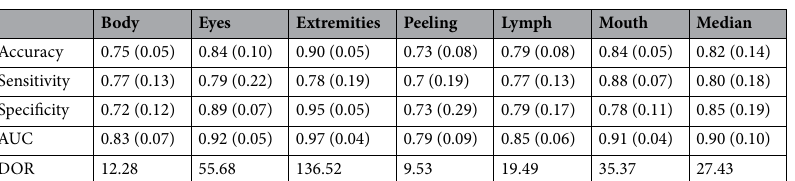
Table 2. Summary of tenfold cross validation results across KD clinical criteria.